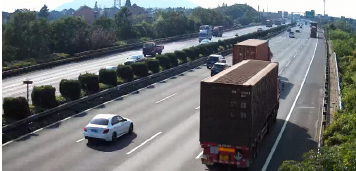
Figure 13. The real situation of Scene 3.